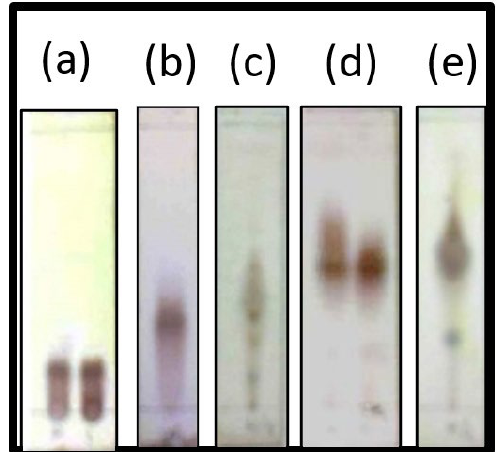
Fig. 2. Profiles of TLC chromatogram of fraction D; (a) Eluent n-hexane : ethyl acetate 90%, (b) Eluent n-hexane ethyl acetate 85%, (c) Eluent n-hexane : ethyl acetate 80%, (d) Eluent n-hexane : ethyl acetate 75%, (e) Eluent n-hexane : ethyl acetate